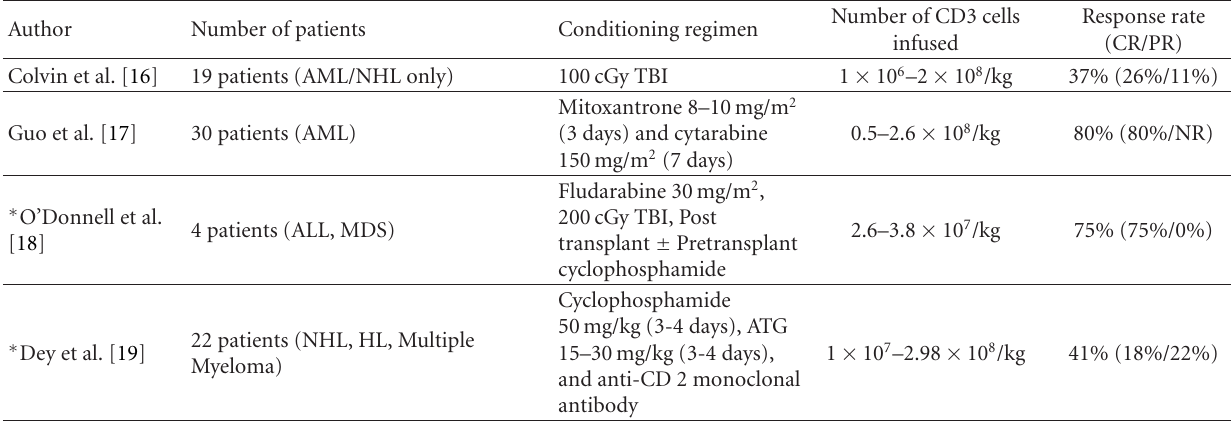
Table 1: Summary of nonengraftment cellular therapy